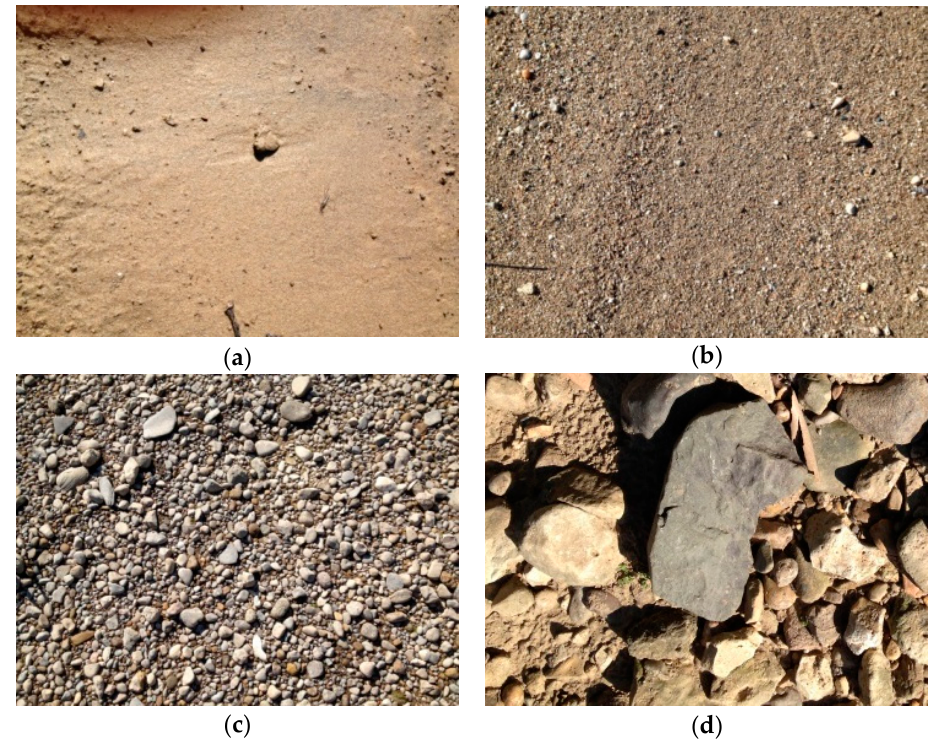
Figure 9. Bottom types identified for the Wabash River and the Tippecanoe River: ( a ) fines; ( b ) sand; ( c ) gravel; and ( d ) cobble.